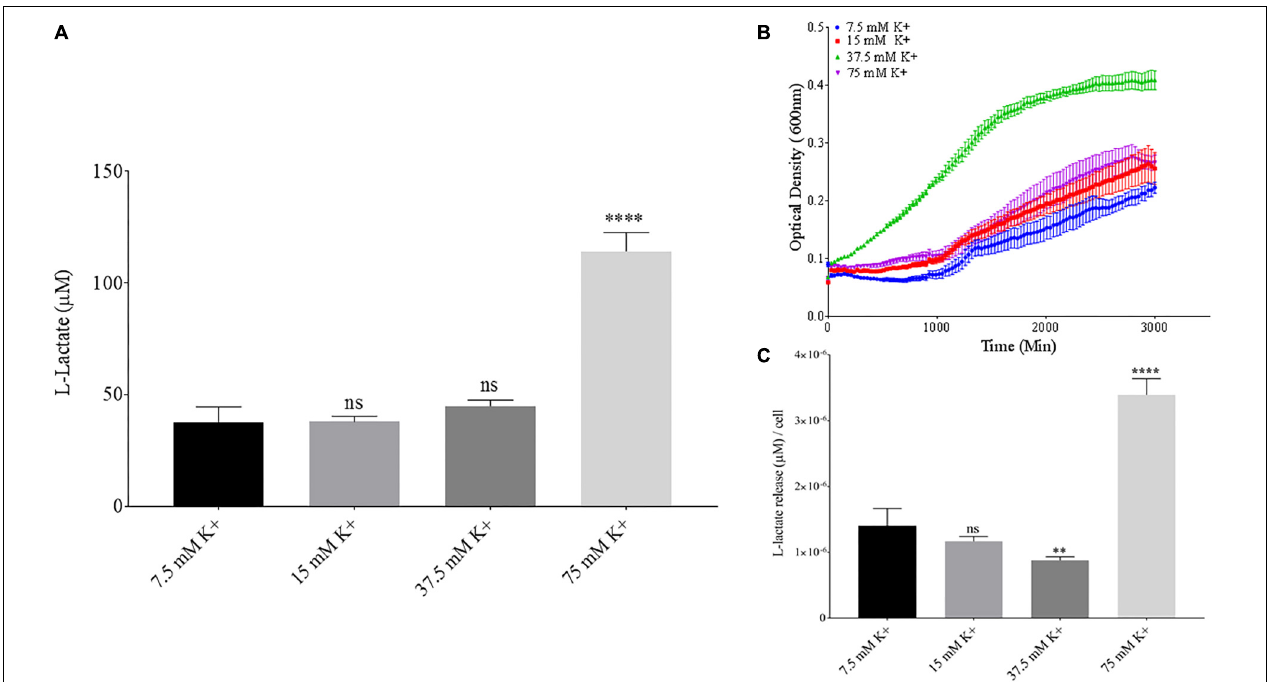
FIGURE 10 | Bacillus pumilus B12 changes L-lactate release in K+ when normalized for growth. (A) Initial measurements of B. pumilus B12 L-lactate release from PLA taken after 48 h. K+ concentration increases are based off standard MSM with glucose (MSM + G). These assays were performed with three biological and three technical replicates. (B) Optical density-based growth curves of B. pumilus B12 in different K+ concentrations taken over 48 h. Each growth curve represents 8 biological replicates. (C) Relative release of L-lactate/cell based on growth after 48 h. ∗∗∗∗ indicates ANOVA p -value ≤ 0.0001, ∗∗ indicates ANOVA p -value ≤ 0.01, and ns indicates ANOVA p -value ≥ 0.05 against MSM + G (7.5 mM K +